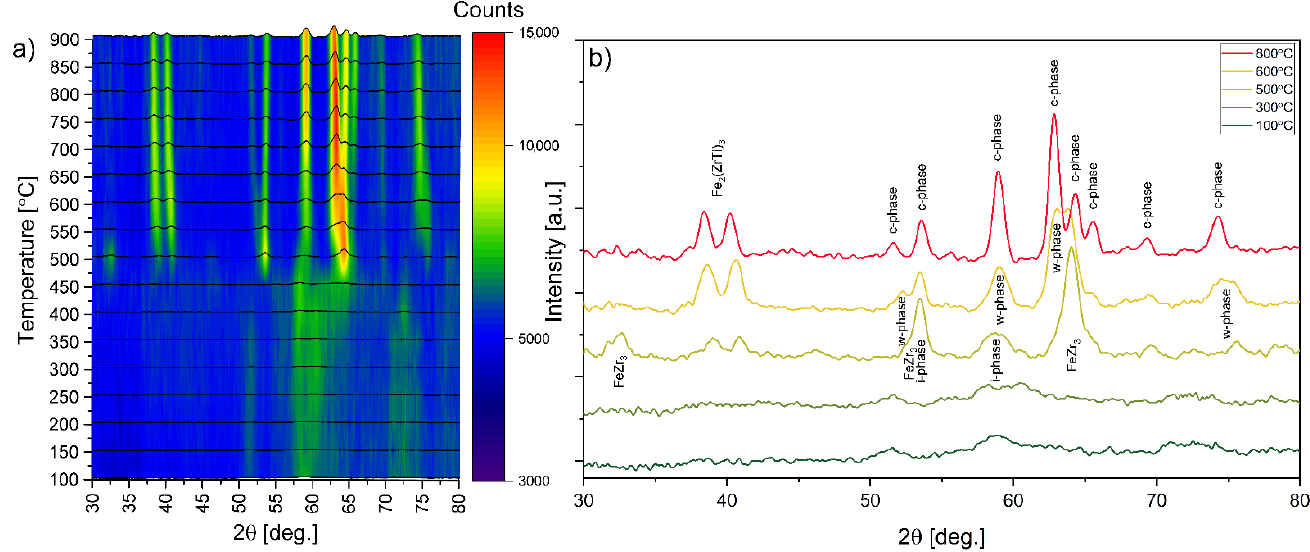
Figure 3. The transformation from the amorphous to the crystal phase for the Ti 45 Zr 38 Fe 17 alloy as seen by neutron diffraction ( a ); the in-situ neutron diffraction patterns at some chosen temperatures ( b ). The pattern for the cubic phase can be indexed in the same crystal phase as the w- phase. The reflections are in similar positions; however, the primary reflections become significantly narrowed. The cubic phase is stable while cooling down to room